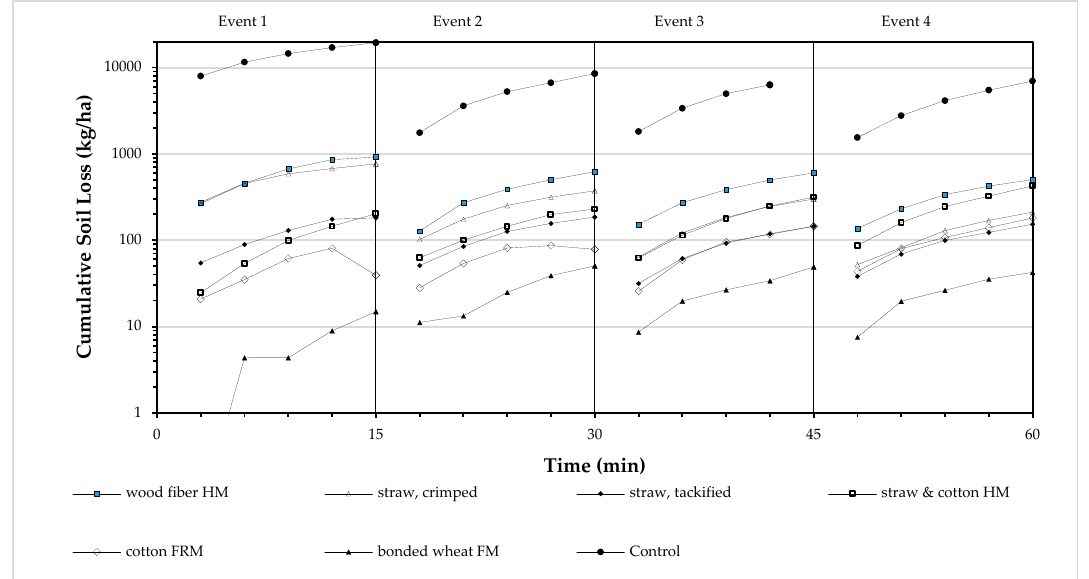
Figure 7. Cumulative soil loss vs. time for six treatments as compared to the control.